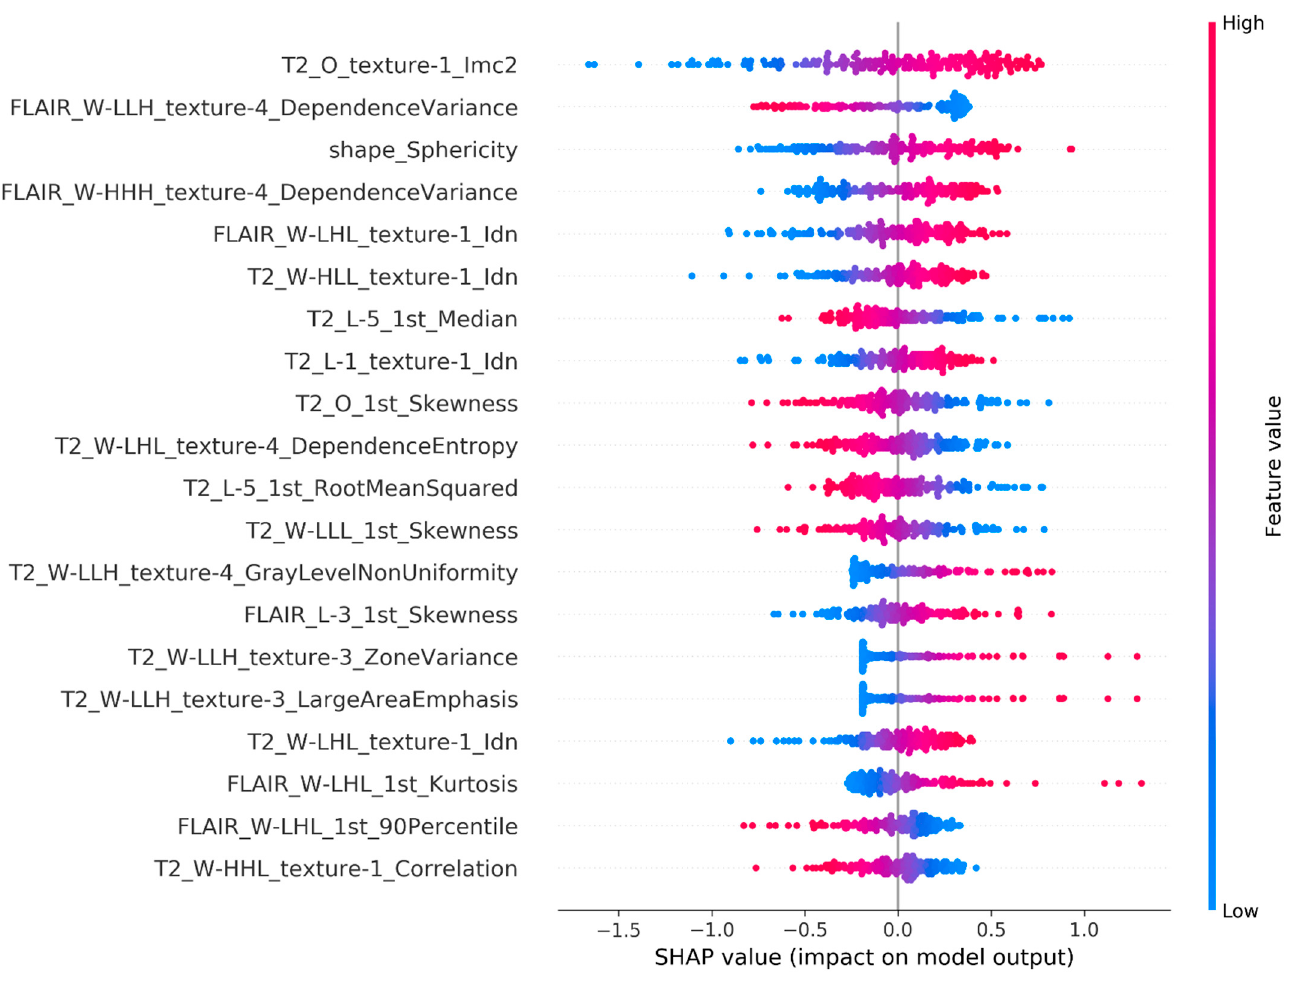
Figure 4. The top 20 radiomics features identified by SHAP for the top Elastic Net model ordered from most to least important. Positive SHAP values are associated with an increase in probability of mutation while negative values with a decrease in probability. Features with higher magnitudes of SHAP values have a greater effect on the model prediction. Each point represents a subject-level SHAP value. Points are colored by their relative value to the overall cohort with high values being shown in red and low values in blue.